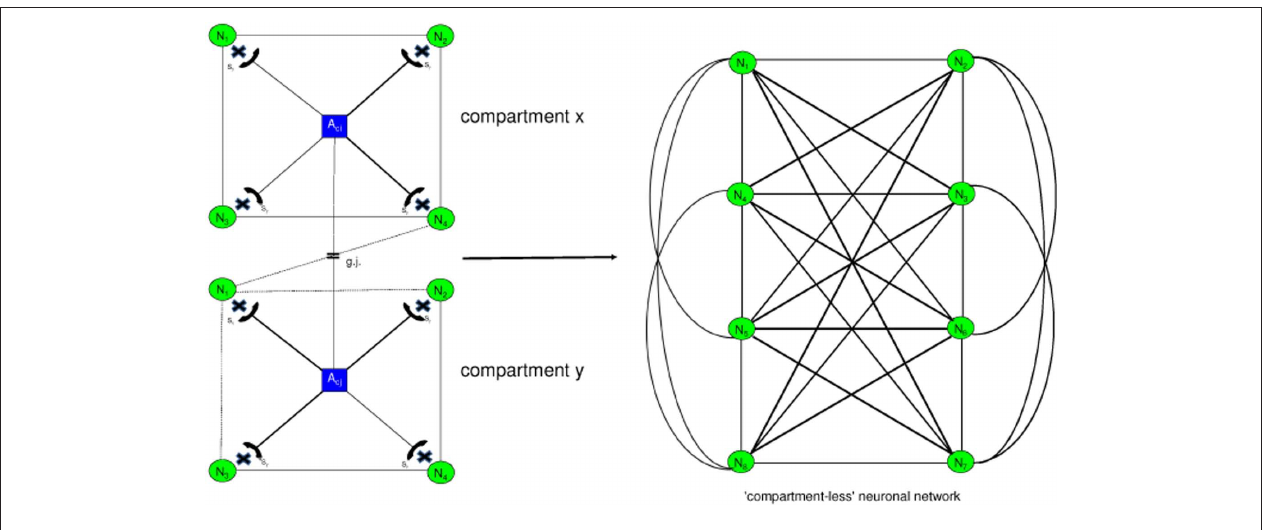
Figure 7 | Loss of glial boundary-setting functions. Generalization of neuronal information processing. In the glial–neuronal compartments (x, y) the astrocytes (Ac ) are unable to modulate any of the neurons (N i, j